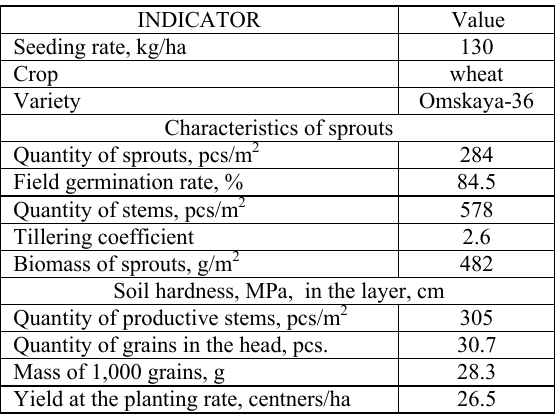
Table 4. Results of the field experiment